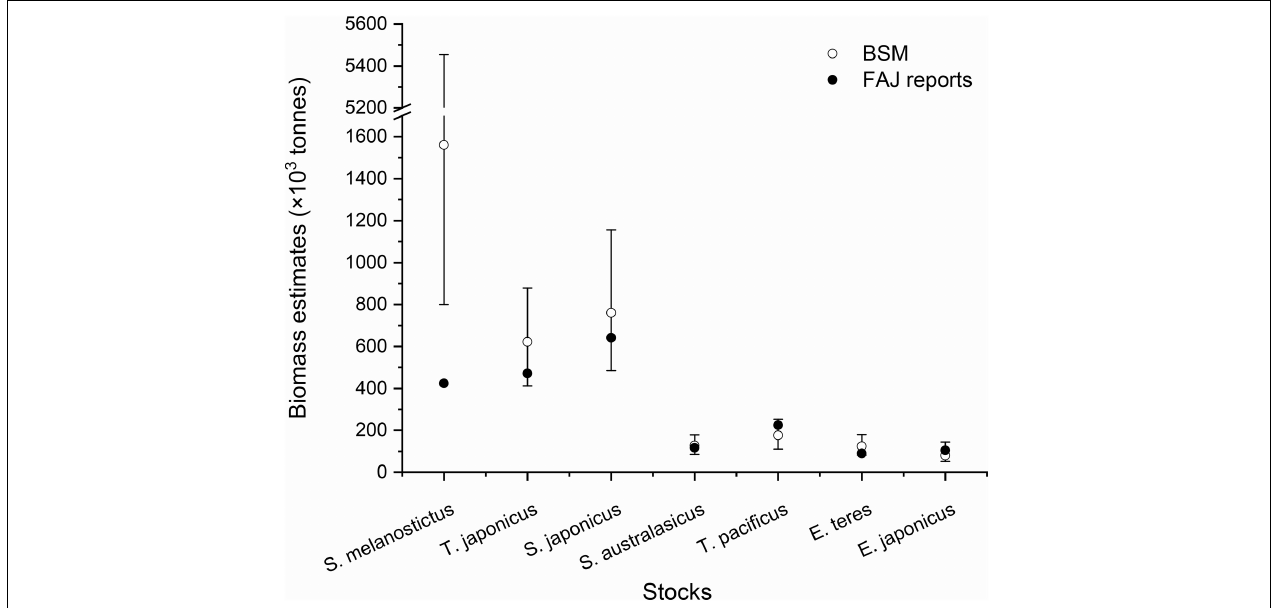
FIGURE 3 | Comparisons of biomass estimates between BSM results (dots with error bars) obtained in this study and FAJ reports. The biomass estimates based on FAJ were re-assessed values treated as “true values”. The other five stocks in question ( D. hypselosomus , S. niphonius , T. modestus , M. cinereus , and U. edulis ) did not have biomass data in the FAJ